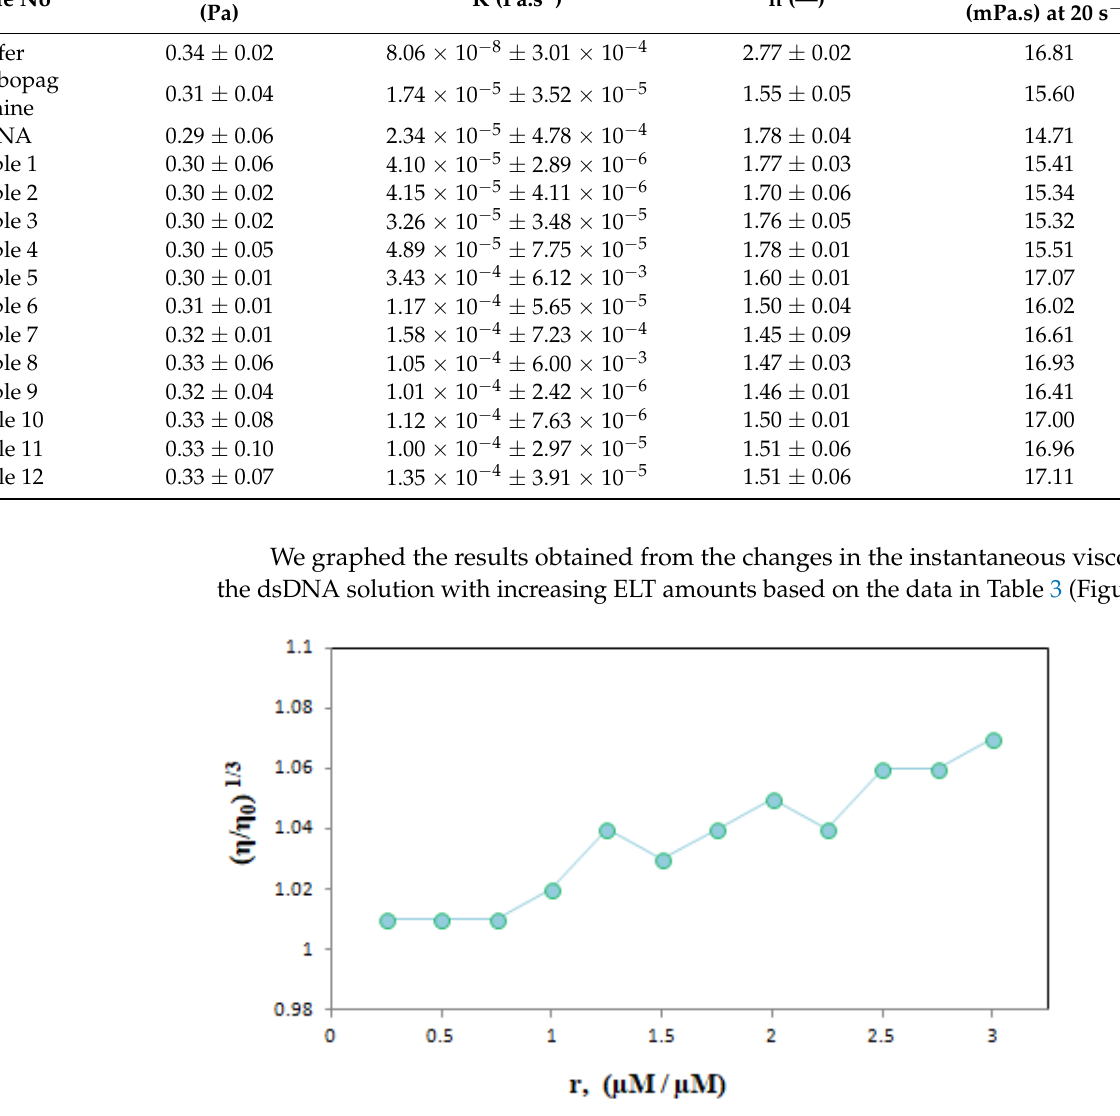
Table 3. The Herschel–Bulkey parameters and calculated instantaneous viscosities at 20 s − 1 .